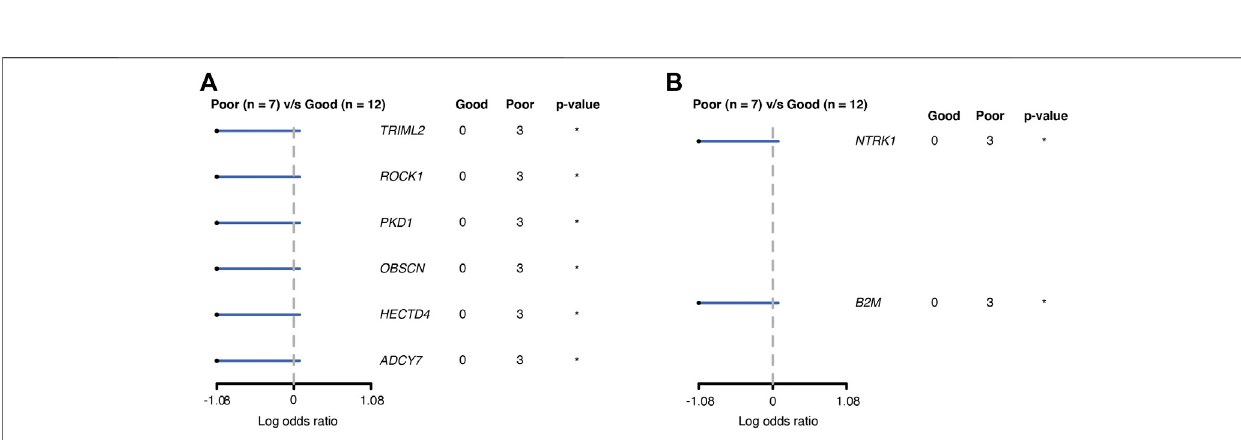
Frontiers in Molecular Biosciences |